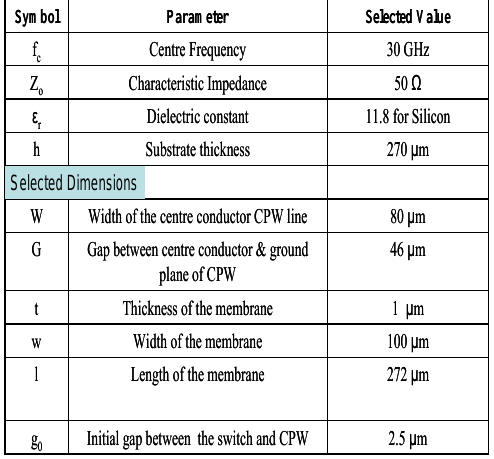
Table III: Comparative study of the effect of number of the air-bridges on RF performance